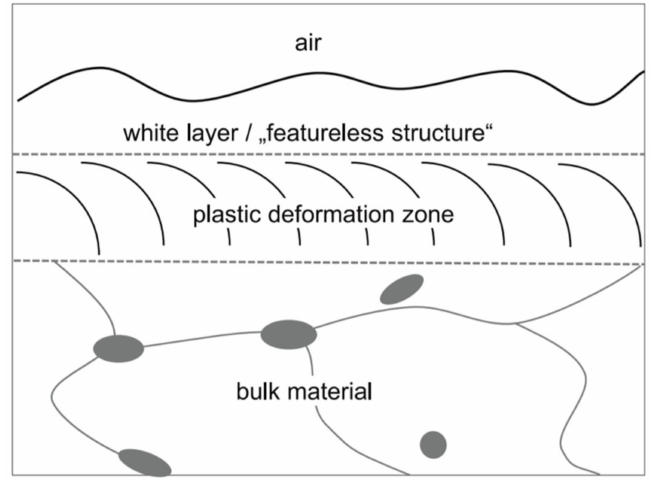
Figure 25. Surface morphology of a white layer